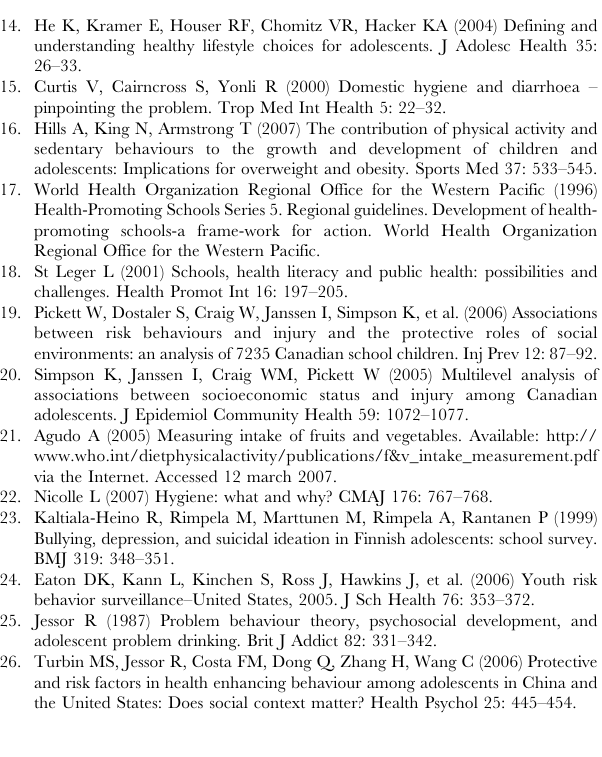
Table S1 Results of multivariate logistic regression analyses for the association of risk and healthy lifestyle behaviours to ever being bullied among adolescents aged 13–15 years old in 9